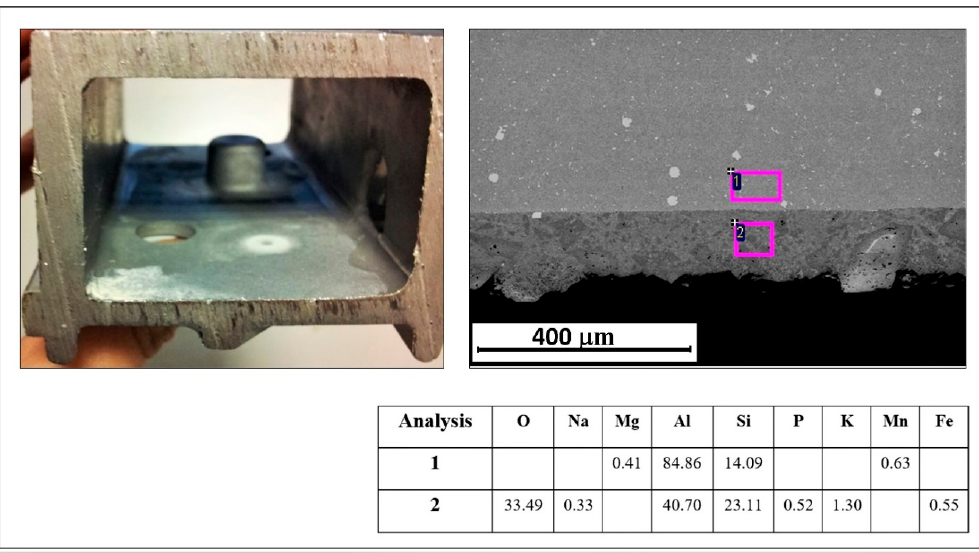
Figure 15. Visual inspection on cermet and SEM image with results of EDS analysis (wt%). The OM analyses on the as-cast samples show, for all the samples, a typical microstructure